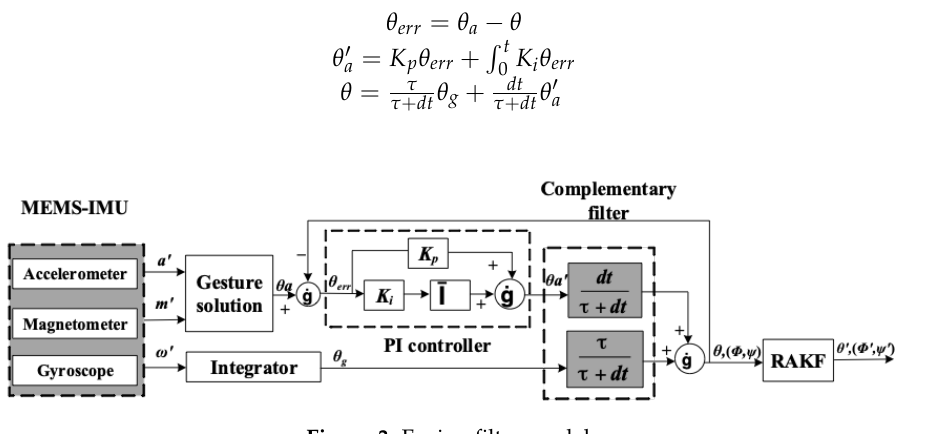
Figure 3. Fusion filter model.